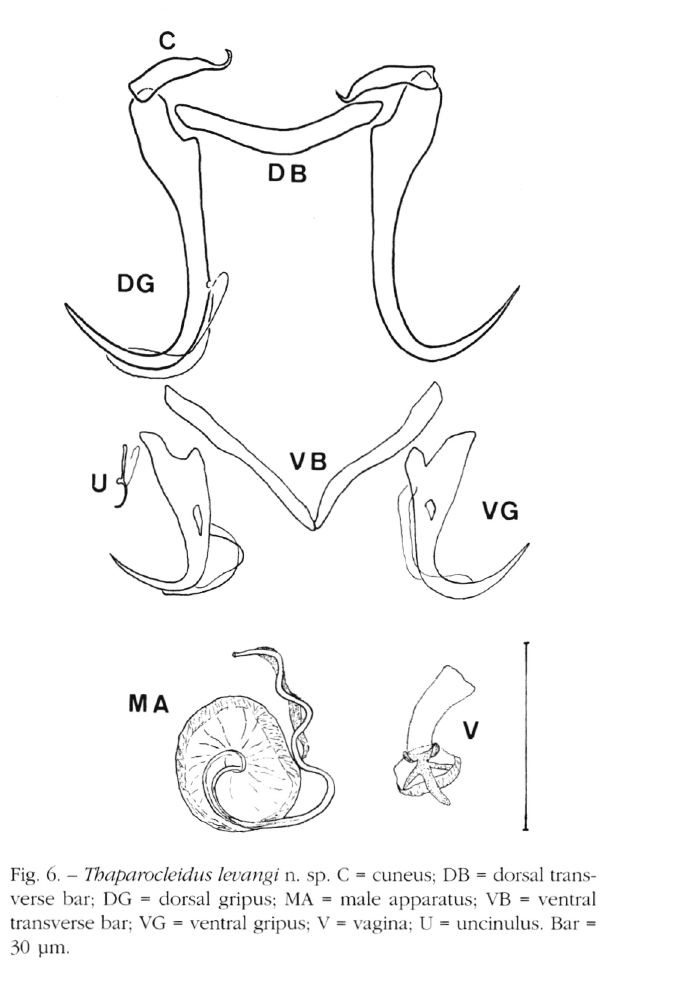
Fig. 6. - Thaparocleidus levangi n. sp. C = cuneus; DB = dorsal trans­ verse bar; DG = dorsal gripus; MA = male apparatus; VB = ventral transverse bar; VG = ventral gripus; V = vagina; U = uncinulus. Bar = 30 |jm.